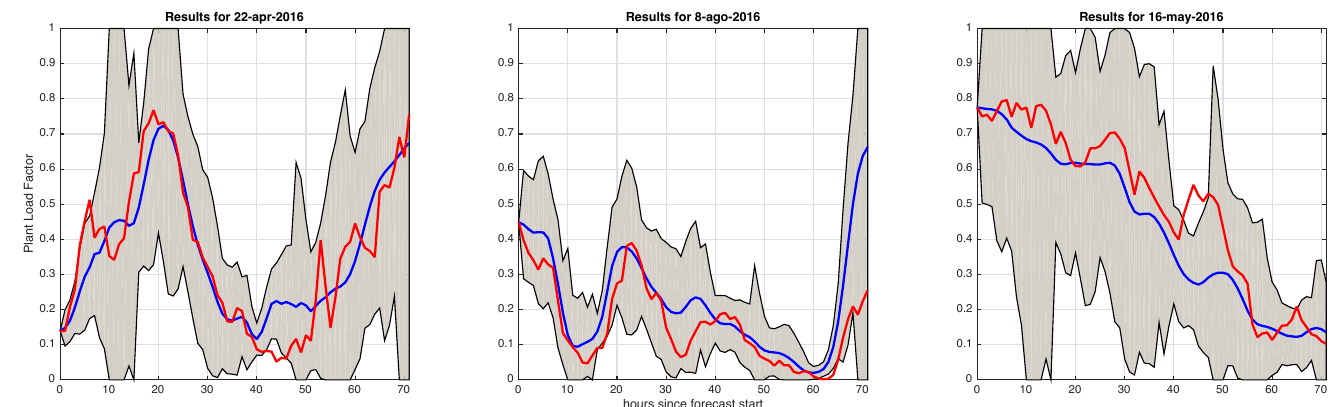
Figure 10. Wind-energy bands for the same days when θ = 0.01 instead of θ = 0.05 [ λ = 1].